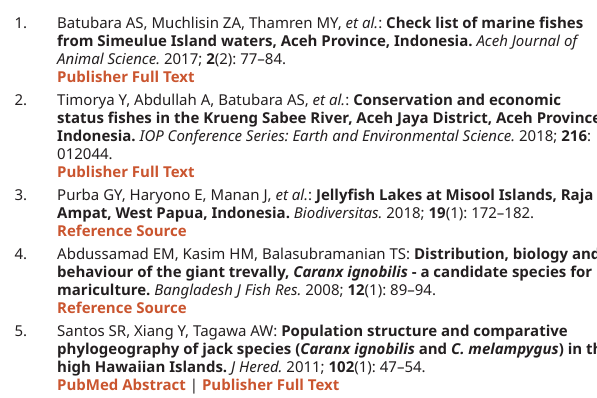
Figshare: Supplementation of rice husk activated charcoal in feed and its effects on growth and histology of the stomach and intestines from giant trevally Caranx ignobilis , https://doi.